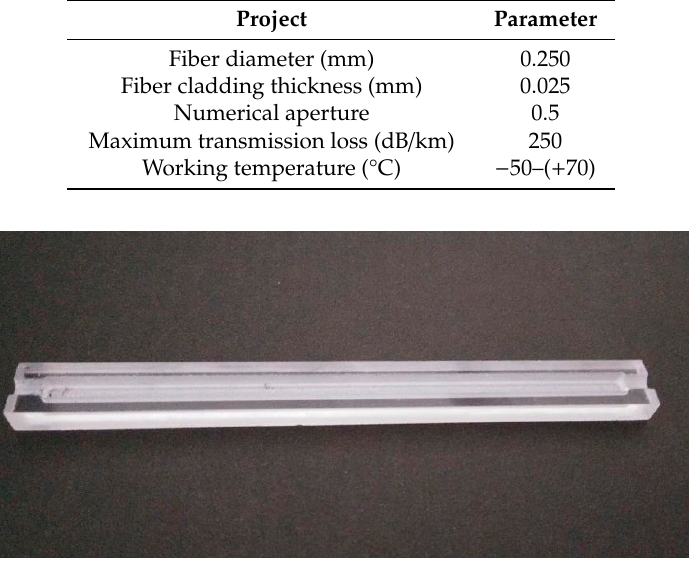
Figure 1. Device for treating POFs.